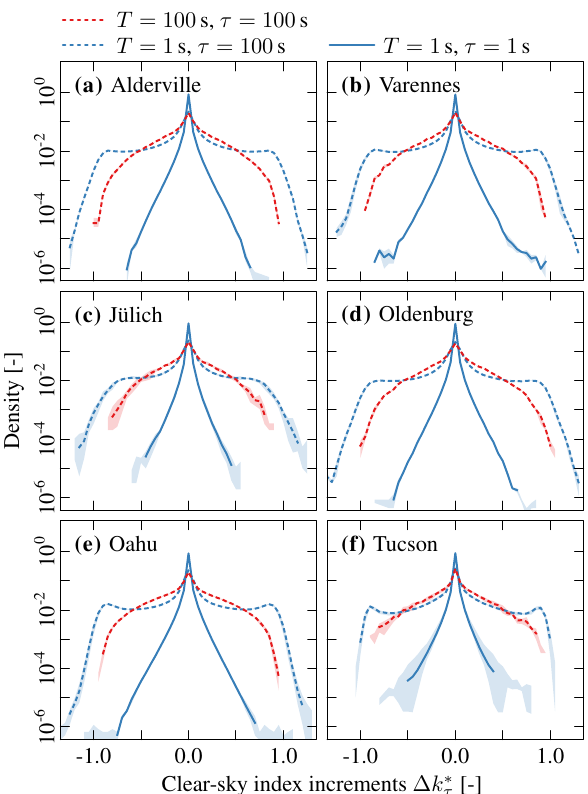
Figure 5. Location-specific distributions of clear-sky index incre- ments (cid:49)k ∗ τ under mixed-sky conditions for averaging times T = 1 and T = 100s, and increment time steps τ = 100 and τ = 1s, using a bin width of 0.05. The spread across individual single-sensor dis- tributions is indicated using semi-transparent coloring for all bins with data from at least two sensors. The averages of the single- sensor densities are presented as solid or dashed lines for the bins that contain data from every